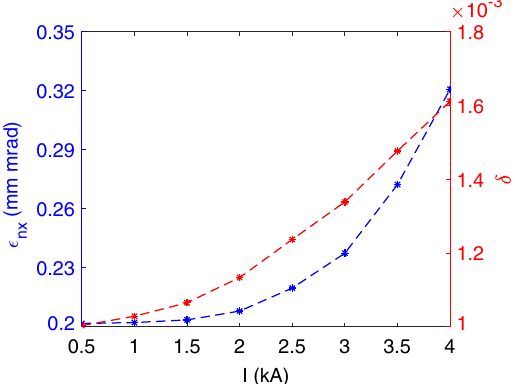
FIG. 4. The normalized horizontal emittance and energy spread of the Gaussian electron beams with different peak current at the end of the delay system.